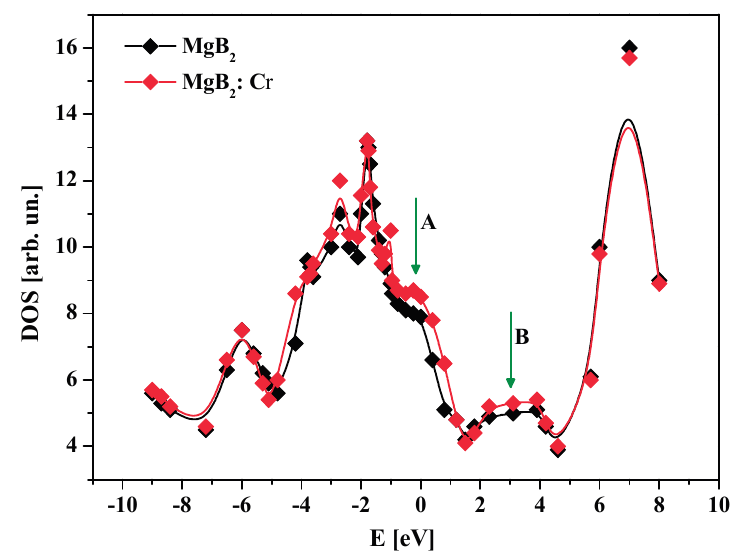
Figure 4. Density of electronic states for MgB 2 and Cr doped MgB 2 .